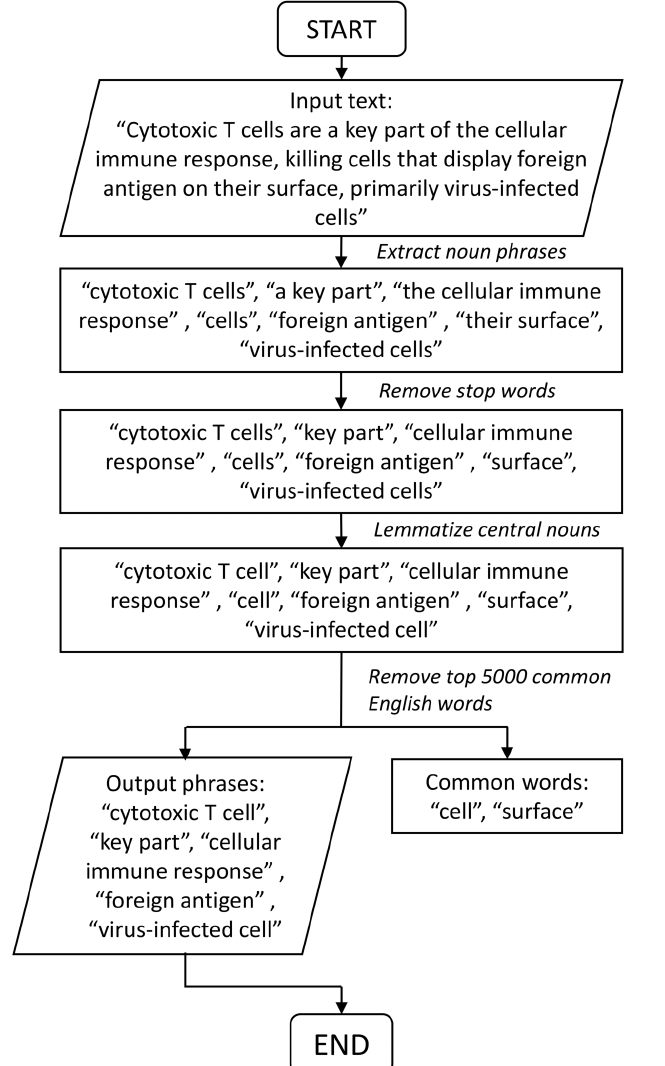
Figure 2. Workflow of noun phrase